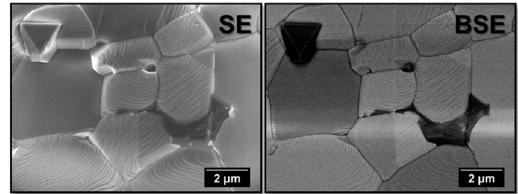
Figure 2. SE and BSE SEM images of triangular precipitates at grain boundary of SnMnNb